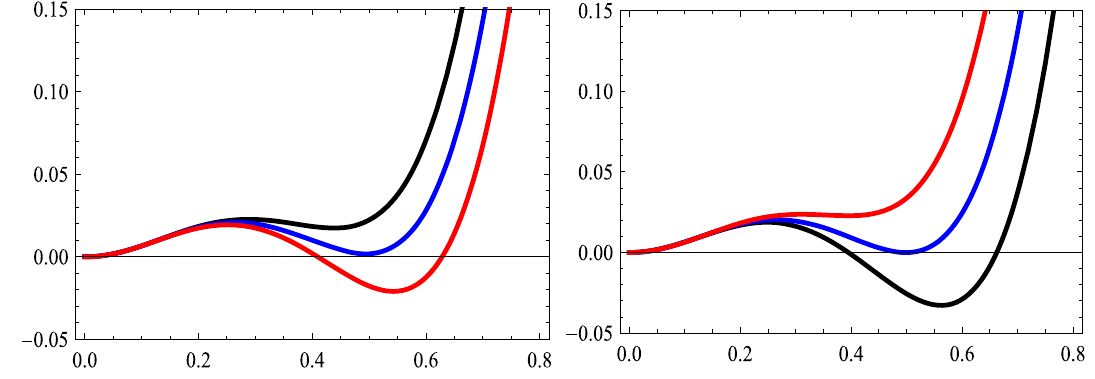
Fig. 4 T (blue) and H Q (black) versus r + for ν (cid:10)= − 2 1 . 06(black) , 1 . 13(blue) , 1 . 25(red). Right: a = 1 . 4 and α = 1 . 98(black) , 2 . 023(blue) , 2 . 08(red)